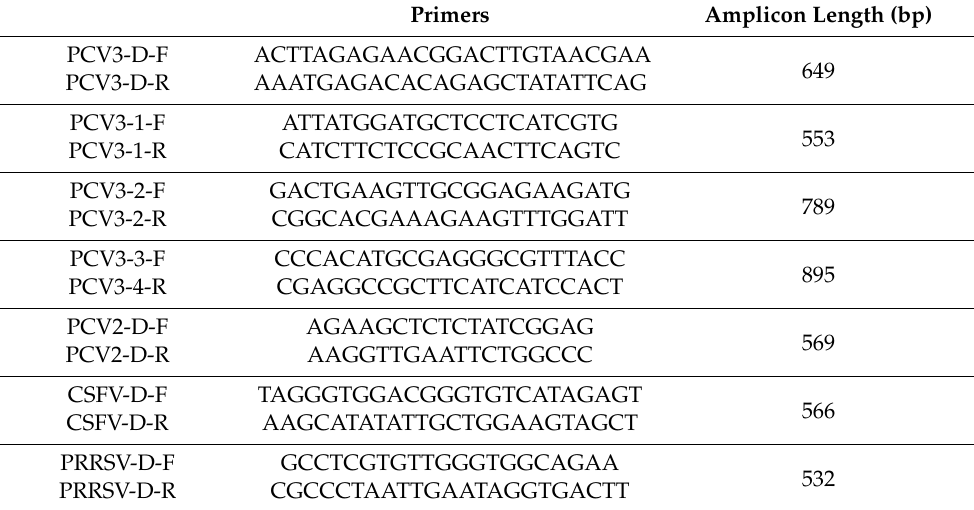
Table 1. Primers used in this